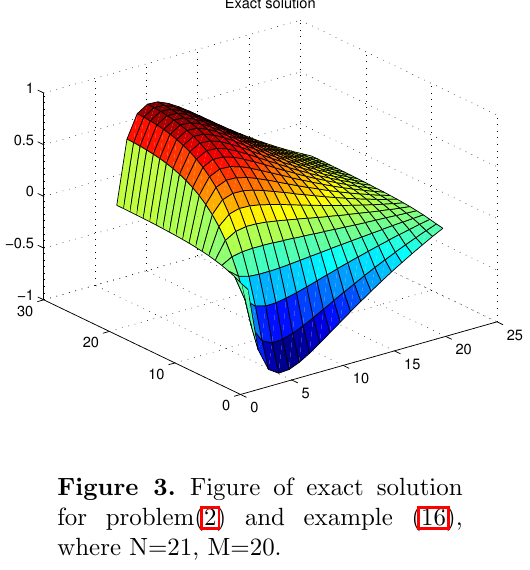
Figure 3. Figure of exact solution for problem(2) and example (16), where N=21, M=20.